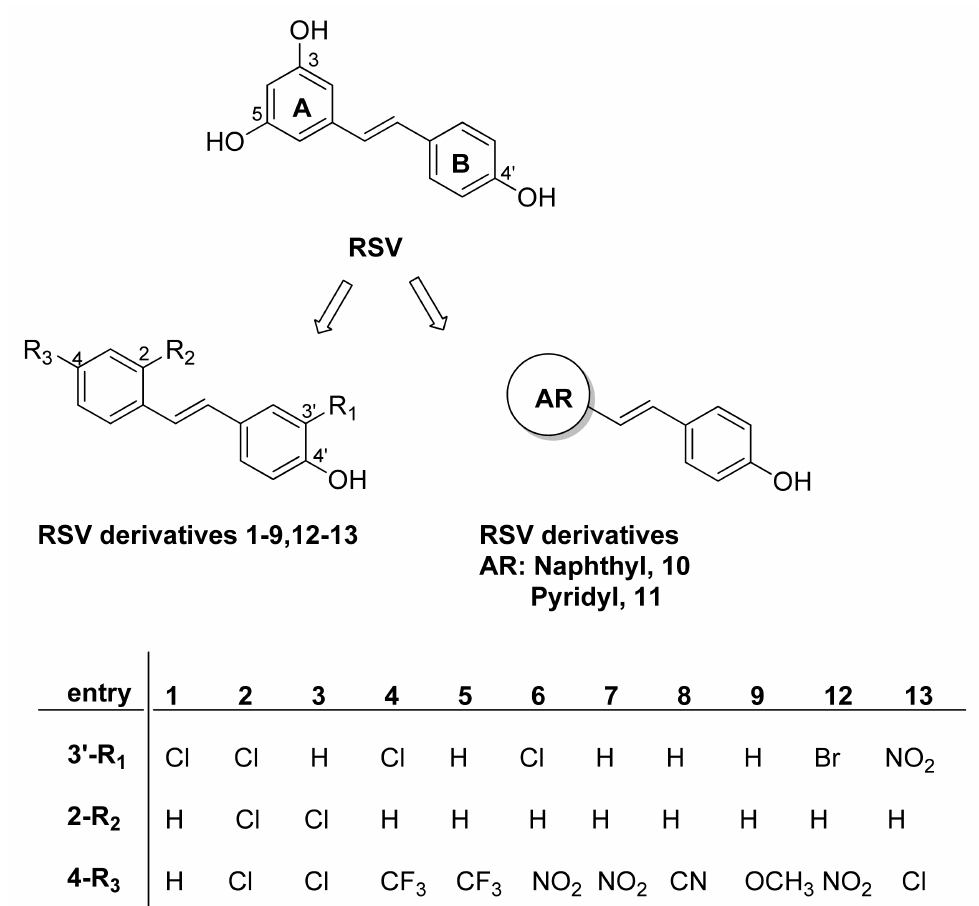
Figure 1. Resveratrol (RSV) and its derivatives 1 – 13